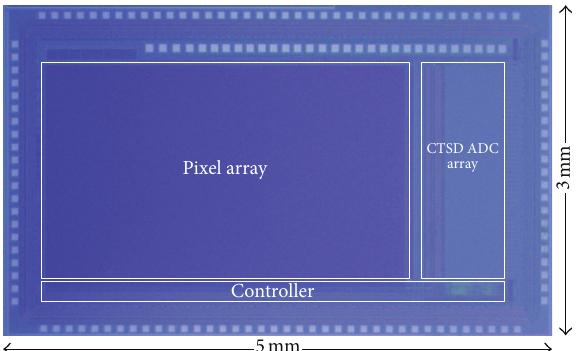
Figure 11: Chip microphotograph.